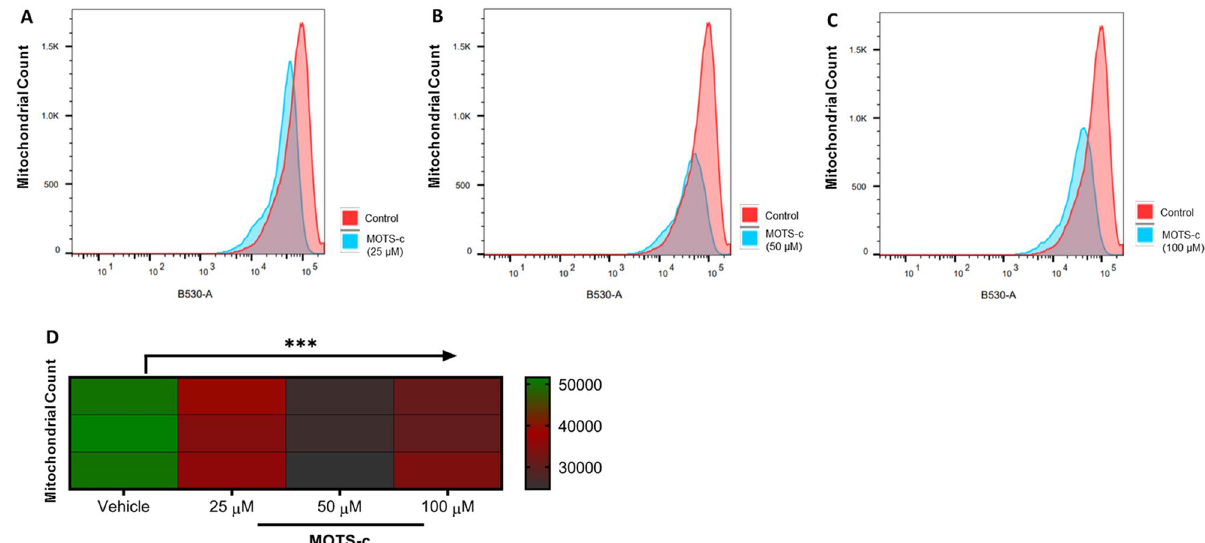
Figure 3. Treatment of U-2 OS cells with MOTS-c depleted the total number of mitochondria as measured by MitoTracker Green. Representative flow cytometry plots ( A – C ) show the intensity of MitoTracker Green in vehicle or MOTS-c and ( D ) Heatmap indicates changes in mitochondrial number w.r.t. vehicle control. U-2 OS cells grown in Dulbecco’s modified Eagle’s medium (DMEM) supplemented with 10% fetal bovine serum (FBS) plus 1% pen-strep were treated with vehicle (Nuclease-Free Water) or MOTS-c (25, 50 or 100 μM) for 48 h and flowcytometry was performed to quantify the number of mitochondria using MitoTracker Green, which localizes to mitochondria regardless of mitochondrial membrane potential. Data are means ± SEM of three experiments. Statistical analysis was conducted using ordinary one-way ANOVA followed by Dunnett’s multiple comparisons test vs vehicle; results are presented as ***p < 0.001 vs.